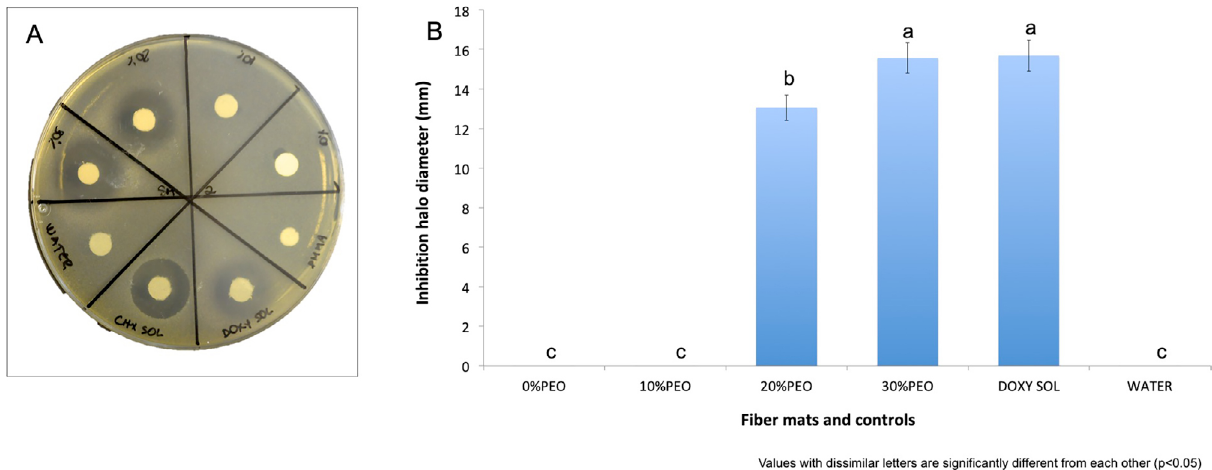
Figure 3- Comparison of inhibition halo size (mm) against S. mutans formed around the different fiber mats and controls. 3A: Image of inhibition halos; 3B: graphic representation of inhibition halo measurements